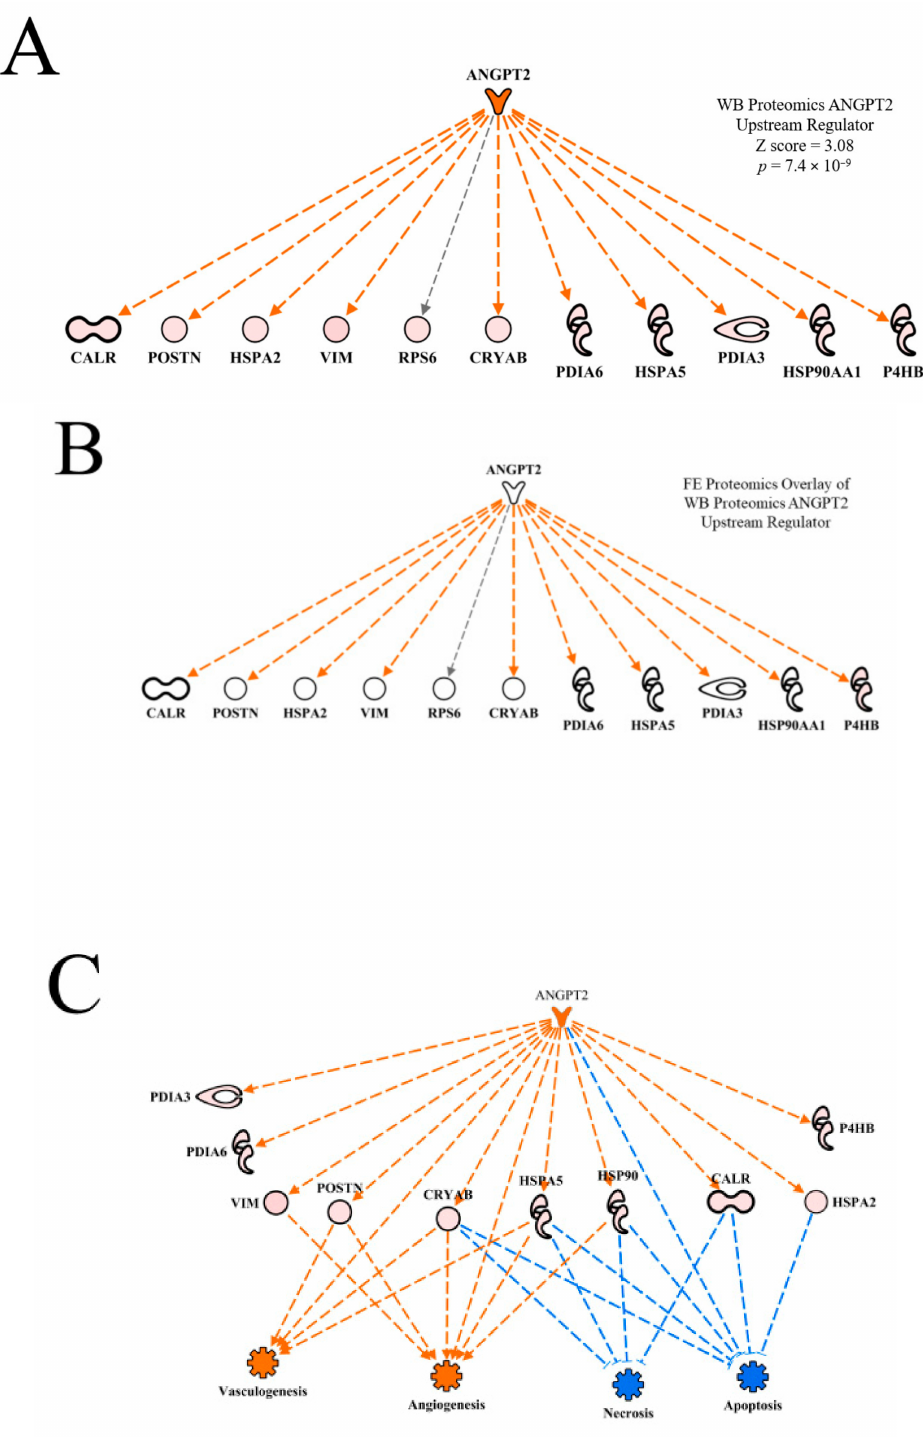
Figure 4. The upstream regulatory network of proteins displayed in hierarchical format for Angiopoeitin 2 (ANGPT2) used in the prediction of activation of this molecule (activation Z score and p value of overlap as shown in ( A )). Overlay of the feed efficiency (FE) proteomics dataset from Kong et al. [11] reveals no commonality of differentially expressed proteins between the wooden breast (WB) and FE data ( B ). A regulatory network for ANGPT2 indicates target proteins in the dataset that contributed to the predictions of active vasculogenesis and angiogenesis, and inhibited necrosis and apoptosis is provided in ( C ). Protein abbreviations are defined and differential expression of proteins are provided in Supplementary Table